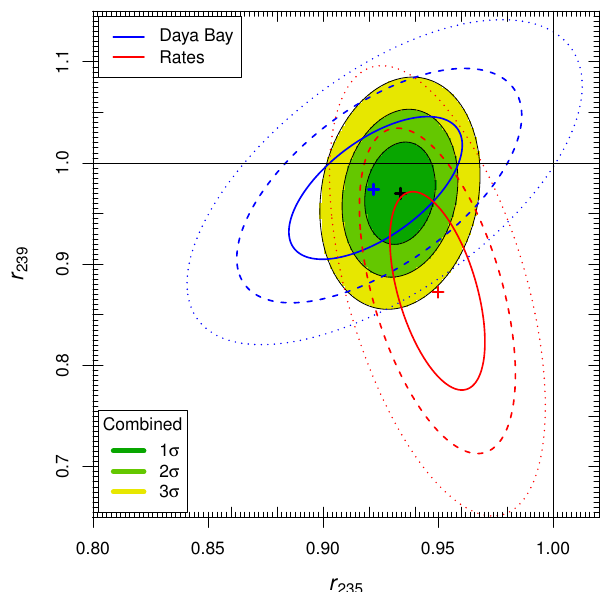
Figure 3 . Allowed regions in the r 235 { r 239 plane obtained from the (cid:12)t of the Daya Bay evolution data [11] (Daya Bay), from the (cid:12)t of the reactor rates (Rates), and from the combined (cid:12)t (Combined) with the 235+239 model. The best (cid:12)t points are indicated by crosses. For the Daya Bay and Rates (cid:12)ts the 1 (cid:27) , 2 (cid:27) , and 3 (cid:27) allowed regions are limited, respectively, by solid, dashed, and dotted